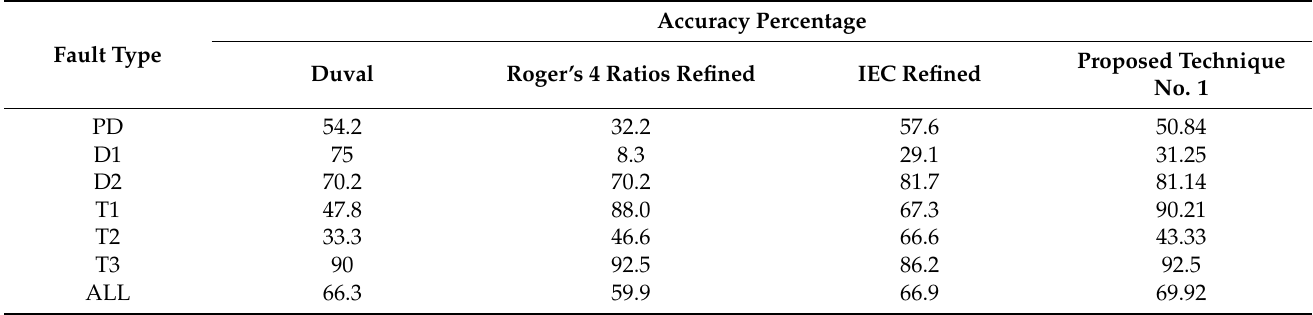
Table 2. Accuracies percentage of the no. 1, Duval, Roger’s four ratios refined and IEC refined